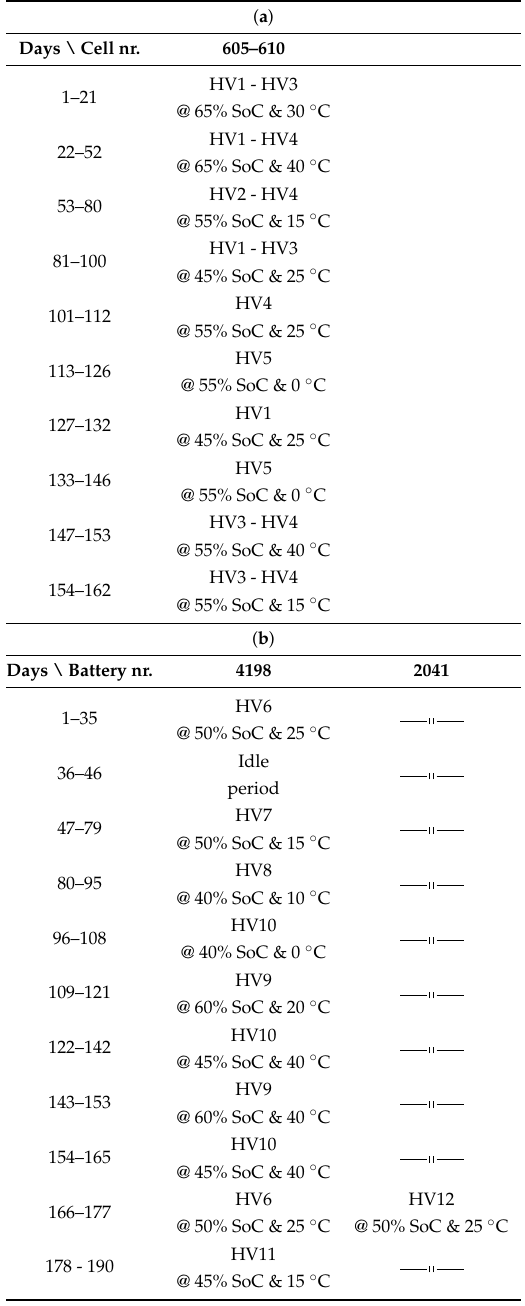
Table 2. Schedule of the performed test sequences containing real-world load profiles, respectively for the conducted tests on cell ( a ) and battery-level ( b